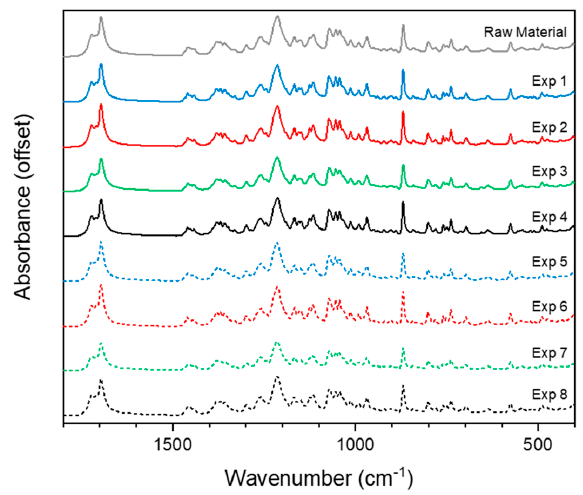
Figure 5. Comparison of the offline FTIR spectra for the lovastatin raw material used to prepare the initial solutions and the lovastatin produced from each antisolvent crystallisation experiment.